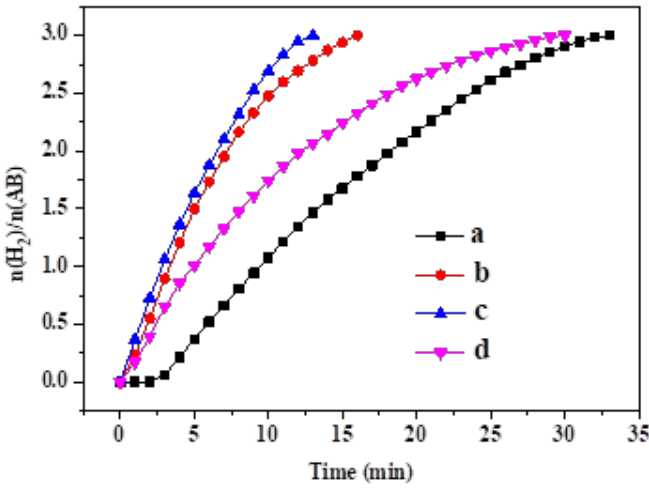
Figure 5. X-ray photoelectron spectrometer (XPS) spectra of ( a ) Co 2p, ( b ) Mn 2p, and ( c ) Mo 3d for the MoO 3 -doped MnCo 2 O 4 (0.10).